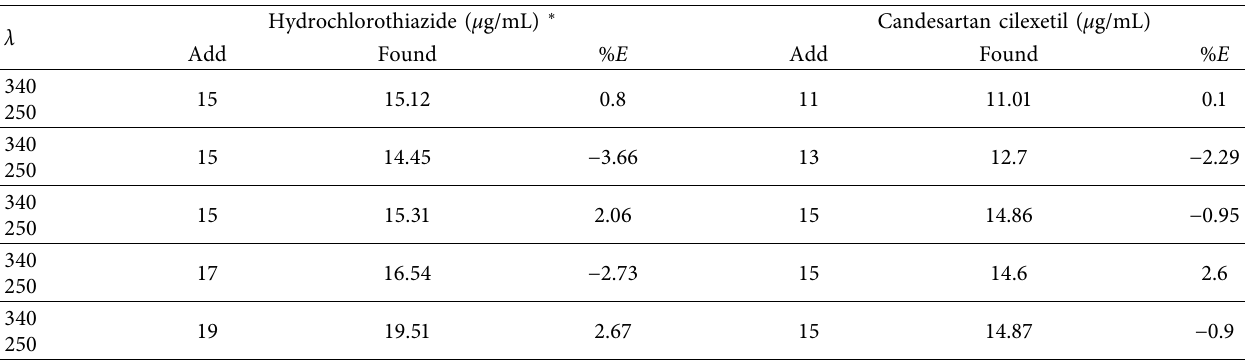
Table 9: Accuracy of the correction absorbance method in the determination of HCT and